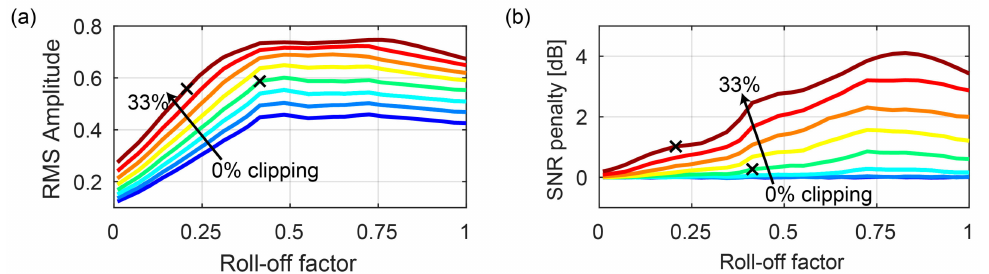
Figure 2. Investigation of clipping on signals with SRRC pulse shape. The simulations were done with two samples per symbol, one million symbols, 30 roll-off factors, and eight clipping values (0, 0.05, 0.10, 0.14, 0.19, 0.24, 0.29, and 0.33). The black crosses indicate examples at ROFs of 0.2 and 0.4, which are discussed in the text in more detail. ( a ) RMS amplitude of clipped and normalized (to maximum) waveforms against roll-off factor. Clipping was done between 0% up to 33%, which corresponds to a saturation of the amplitude at 100% down to 67%. ( b ) Resulting signal-to-noise ratio (SNR) penalty of clipped SRRC waveforms. The SNR was evaluated after matched filtered